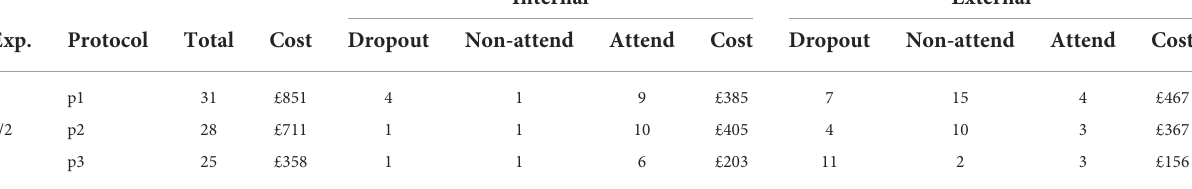
TABLE 2 The number of participants across the protocols and experiments.